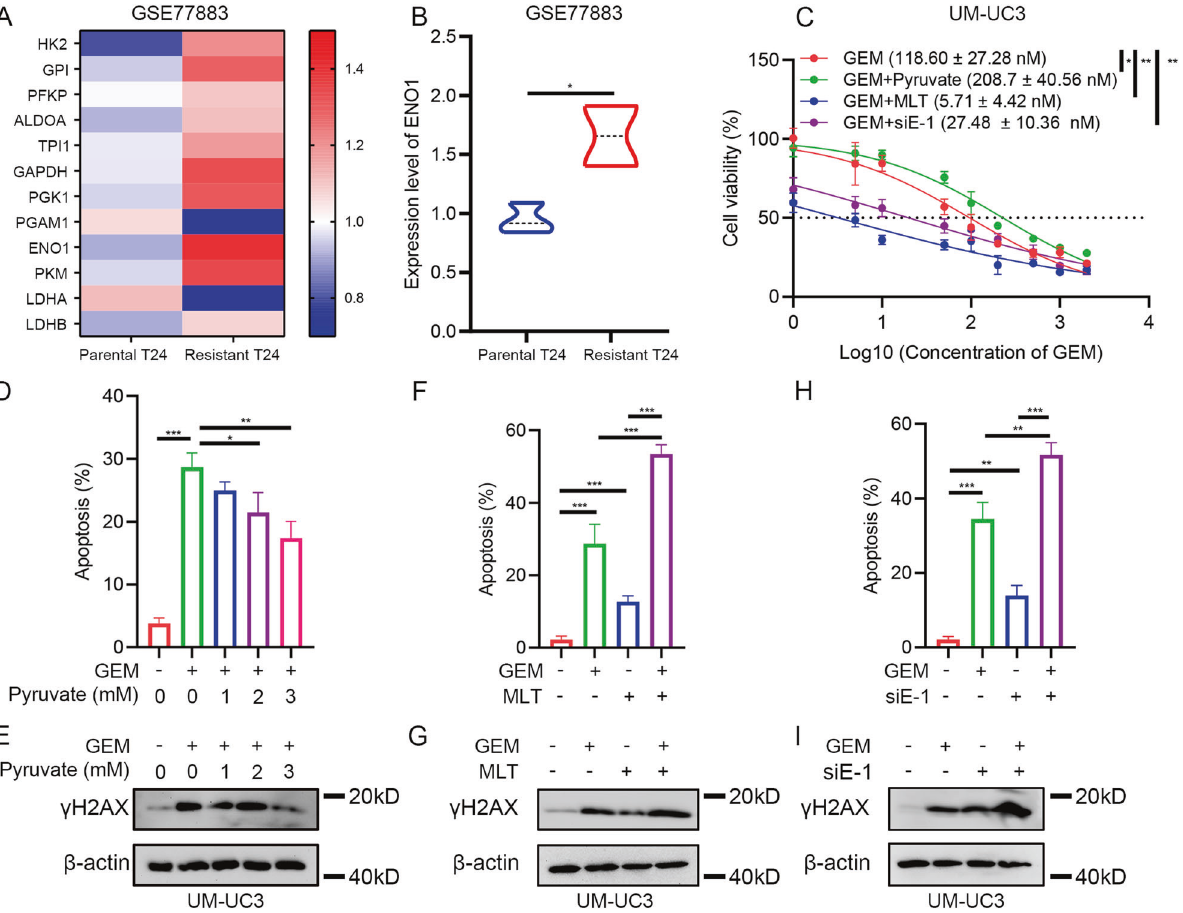
Fig. 4 Melatonin treatment or silencing of ENO1 could promote the cytotoxic effect of gemcitabine. A – B Expression status of glycolysis enzymes in GSE77883. C IC50 value of gemcitabine on BLCA cells with different culture conditions under 48 h culture ( n = 3), negative control siRNA was added. D Statistical analysis of apoptotic cells of UM-UC3 cells after 48 h gemcitabine (0.5 μ M) treatment with exogenous pyruvate (3 mM) supplement ( n = 3). E Western blot assay of γ H2AX alteration in UM-UC3 cells with 48 h gemcitabine (0.5 μ M) treatment and 3 mM pyruvate supplement. F Statistical analysis of apoptotic cells of UM-UC3 cells with 48 h gemcitabine (0.5 μ M) treatment and 24 h 2 mM melatonin treatment ( n = 4). G Western blot assay of γ H2AX alteration in UM-UC3 cells with 48 h gemcitabine (0.5 μ M) treatment and 24 h 2 mM melatonin treatment. H Statistical analysis of apoptotic cells of UM-UC3 cells with 48 h gemcitabine (0.5 μ M) treatment and silencing ENO1 ( n = 3), negative control siRNA was added in “ - ” of siE-1 group. I Western blot assay of γ H2AX alteration in UM-UC3 cells with 48 h gemcitabine (0.5 μ M) treatment and silencing ENO1 , negative control siRNA was added in “ - ” of siE-1 group. * p < 0.05, ** p < 0.01, *** p < (Fig. 4G). Similar results were observed when using ENO1 -speci fi c siRNA combined with gemcitabine in BLCA cells (Fig. 4C, H, I and Supplementary Fig. S8D). To conclude, we demonstrated that enhanced glycolysis limited the ef fi ciency of gemcitabine, while suppressing the glycolysis process with melatonin treatment or silencing of ENO1 promoted the cytotoxic effect of gemcitabine on BLCA cells.